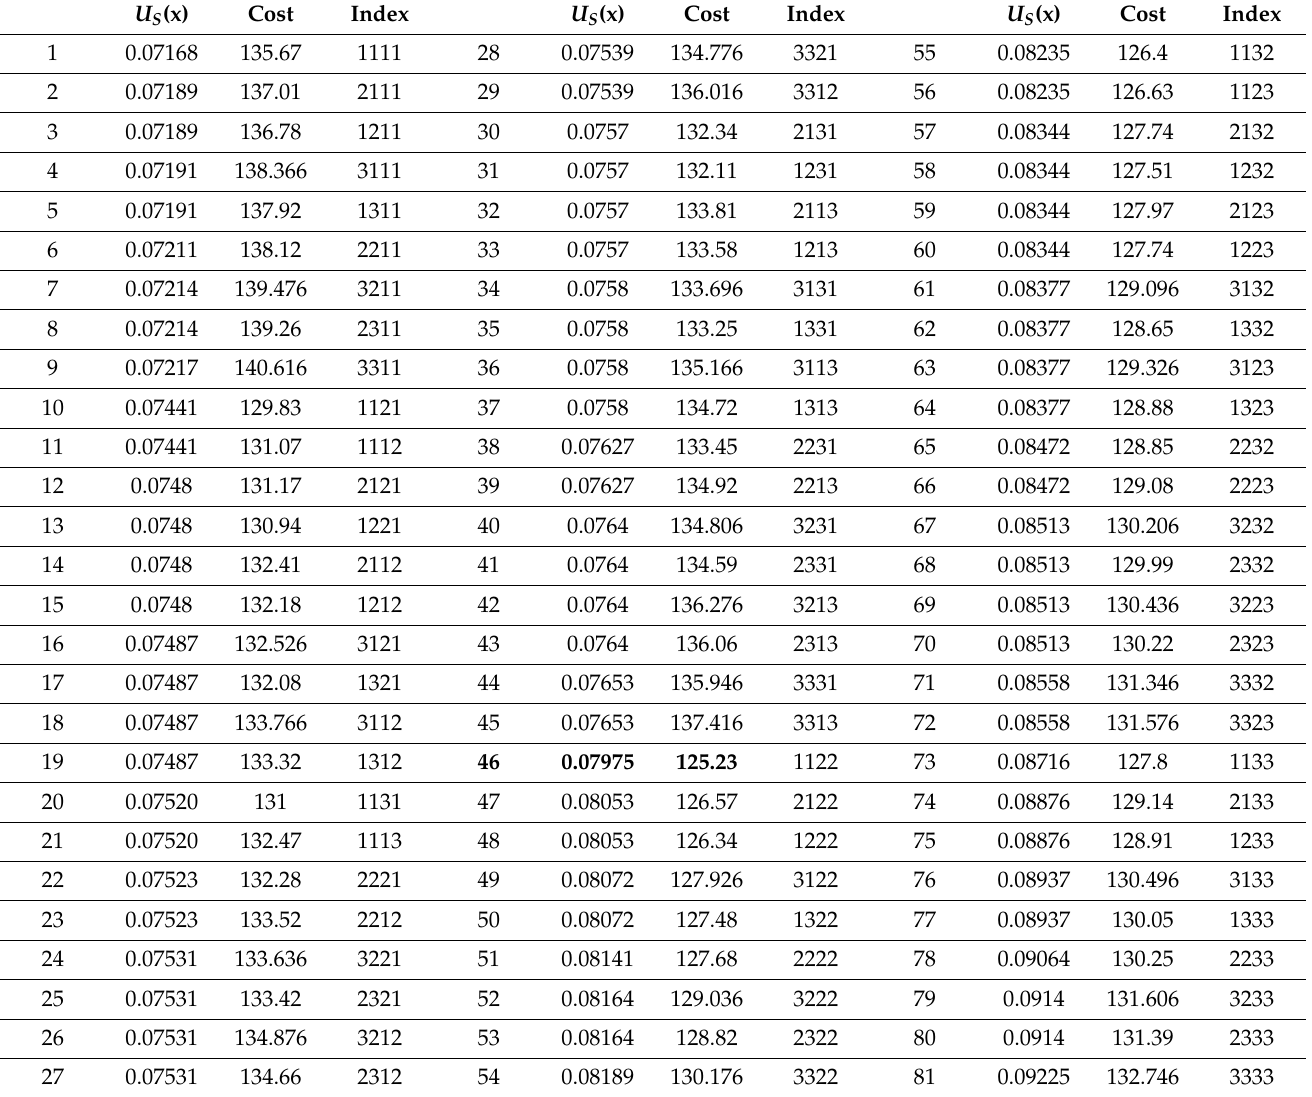
Table 3. Results for optimization process for decision variable n in a four-component